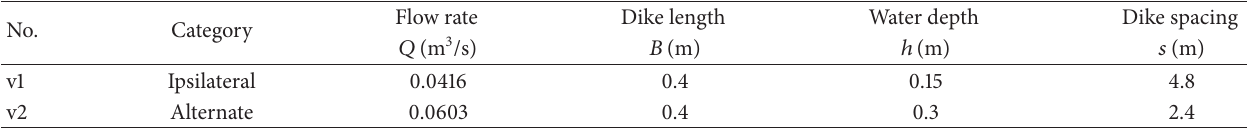
Table 1: Verification